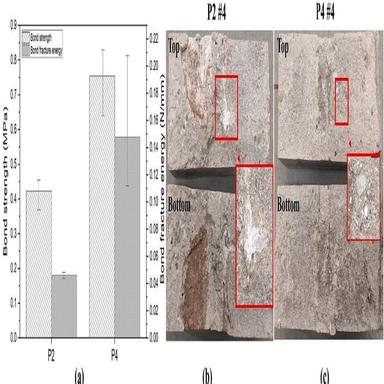
Mean values of bond strength and bond fracture energy for couplets extracted from P2 and P4 (a); Crack surface of the sample from P2 (b); Crack surface of the sample from P4 (c).